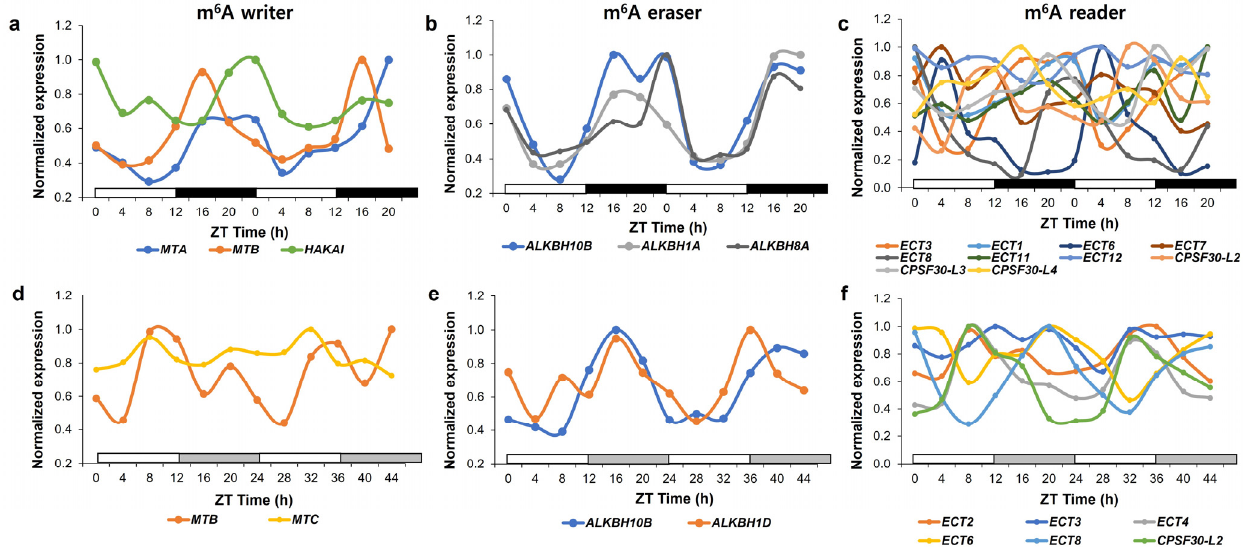
Figure 3. Expression of genes encoding proteins involved in m 6 A modification in plants under diurnal and free-running conditions. Relative expression of rhythmic genes in the m 6 A writer ( a , d ), m 6 A eraser ( b , e ), and m 6 A reader ( c , f ) in diurnal ( a – c ) and free-running conditions ( d – f ) was determined as a normalized value against the maximum value of expression at all-time points. Genes involved in m 6 A metabolism are selected according to [132]. Raw expression data were derived from the DIURNAL project (http://diurnal.mocklerlab.org, accessed on 2 January 2023) and rhythmic genes in diurnal and free-running conditions were determined based on the correction cutoff value = 0.8 and the condition = LDHC and LL23_LDHH (the DIURNAL project), respectively [131]. Overall, it is evident that m 6 A methylation induced by the MTA-MTB methyl writer complex is essential for the photo-input or maintenance of the plant circadian clock, but